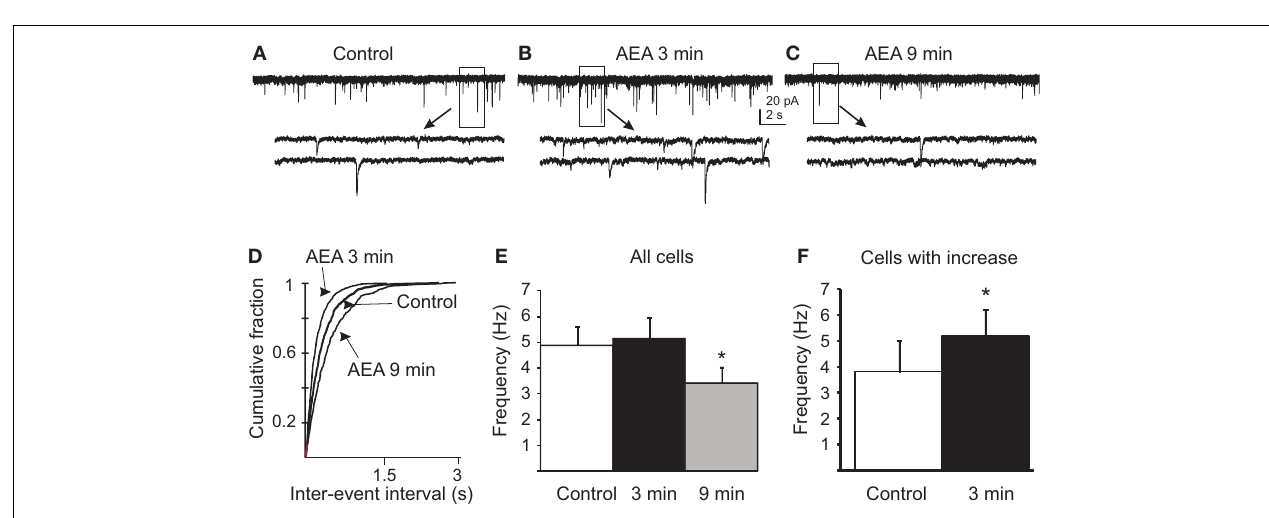
increase at 3min (leftward shift) and a significant decrease at 9min (rightward shift) in mEPSC frequency ( p < 0.02; K–S test). (E) Pooled data from all tested cells showing changes in frequency of mEPSCs caused by 10 µ M AEA at 3 and 9min ( n = 9; * p < 0.05 from control and 3min; ANOVA,Tukey’s). (F) Pooled data from the subset of neurons that responded to AEA with an increase in mEPSC frequency (45%) showing changes in the frequency of mEPSCs at 3min ( n = 5; * p < 0.05, t